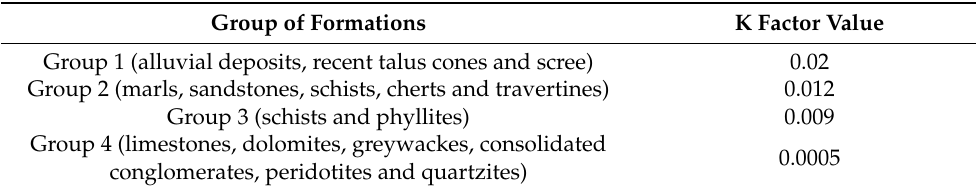
Table 2. Soil erodibility (K) factor values for the four classes of the geological formations of the study area. Group of Formations K Factor Value Group 1 (alluvial deposits, recent talus cones and scree) 0.02 Group 2 (marls, sandstones, schists, cherts and travertines) 0.012 Group 3 (schists and phyllites) 0.009 Group 4 (limestones, dolomites, greywackes, consolidated conglomerates, peridotites and quartzites)